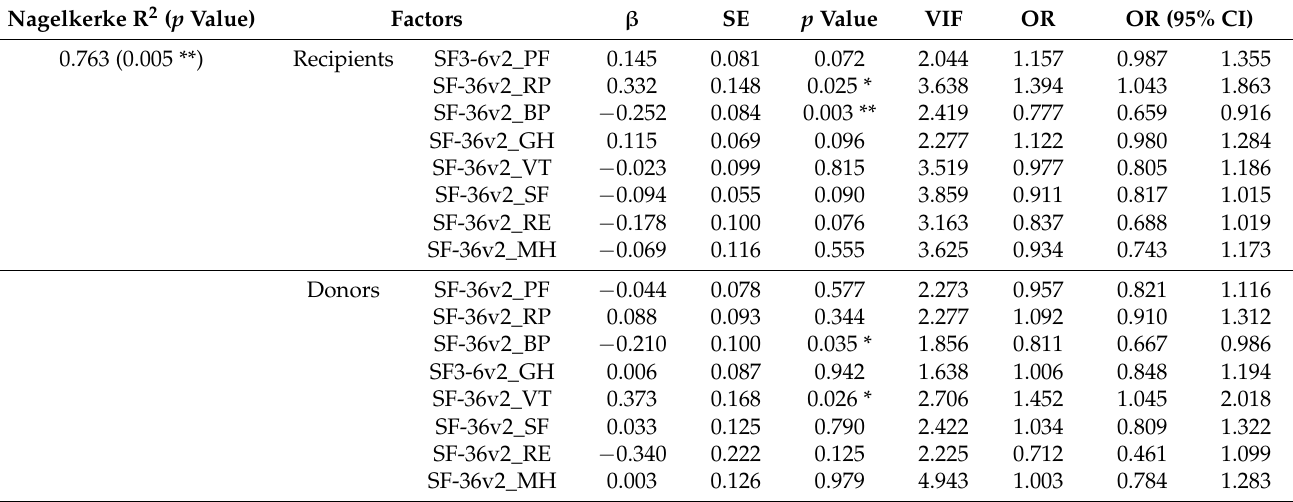
Table 3. Significant impact factors of SF-36v2 on choosing between PEKT and PDKT. * p < 0.05, ** p < 0.01 based on binomial logistic regulation analysis with robust standard errors. Multicollinearity was suspected if the VIF value was greater than 10. * p < 0.05, ** p < 0.01: significant impact factor on choosing PEKT or PDKT for recipients and donors.